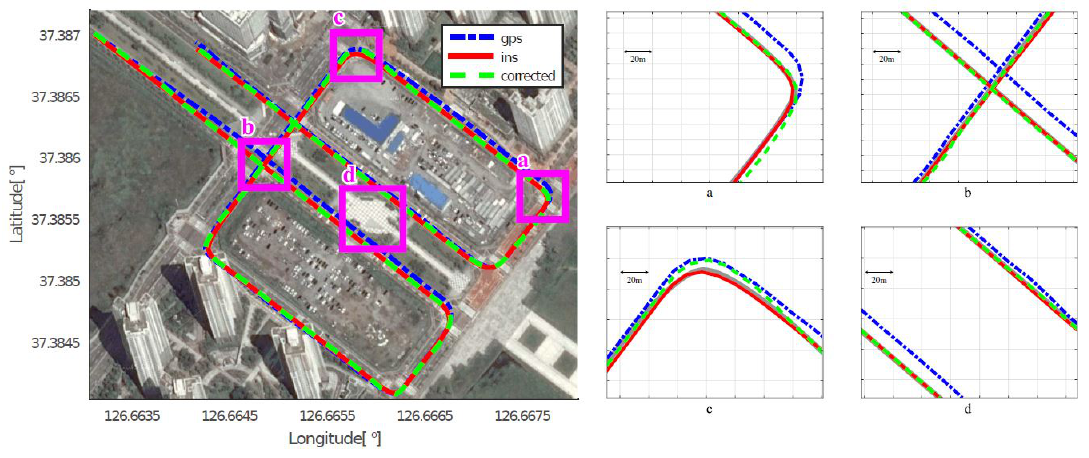
Figure 13. Experimental results for Course